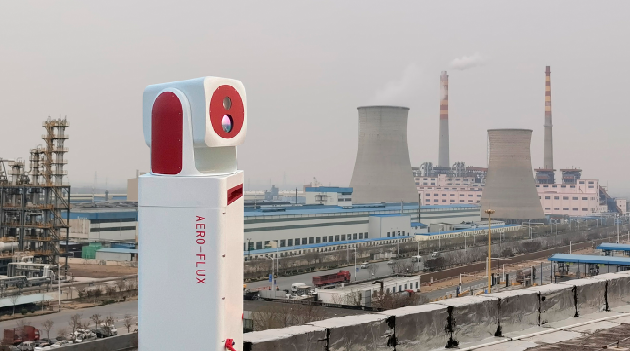
Figure 1. The CDWL on the rooftop of the main building of Shandong Chambroad Co., Ltd.